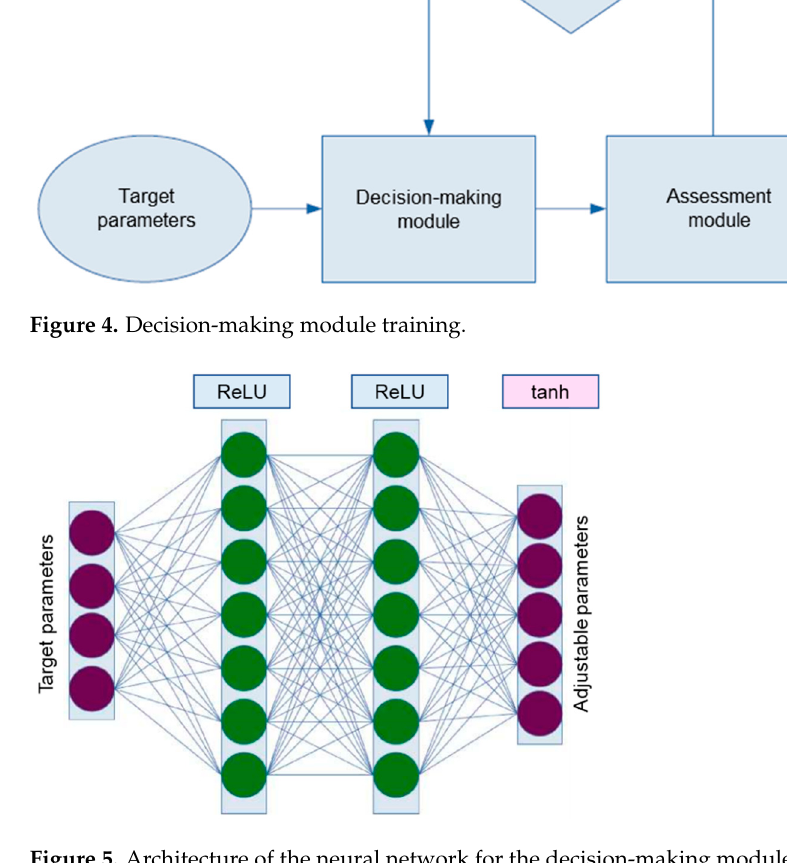
Figure 5. Architecture of the neural network for the decision-making module.